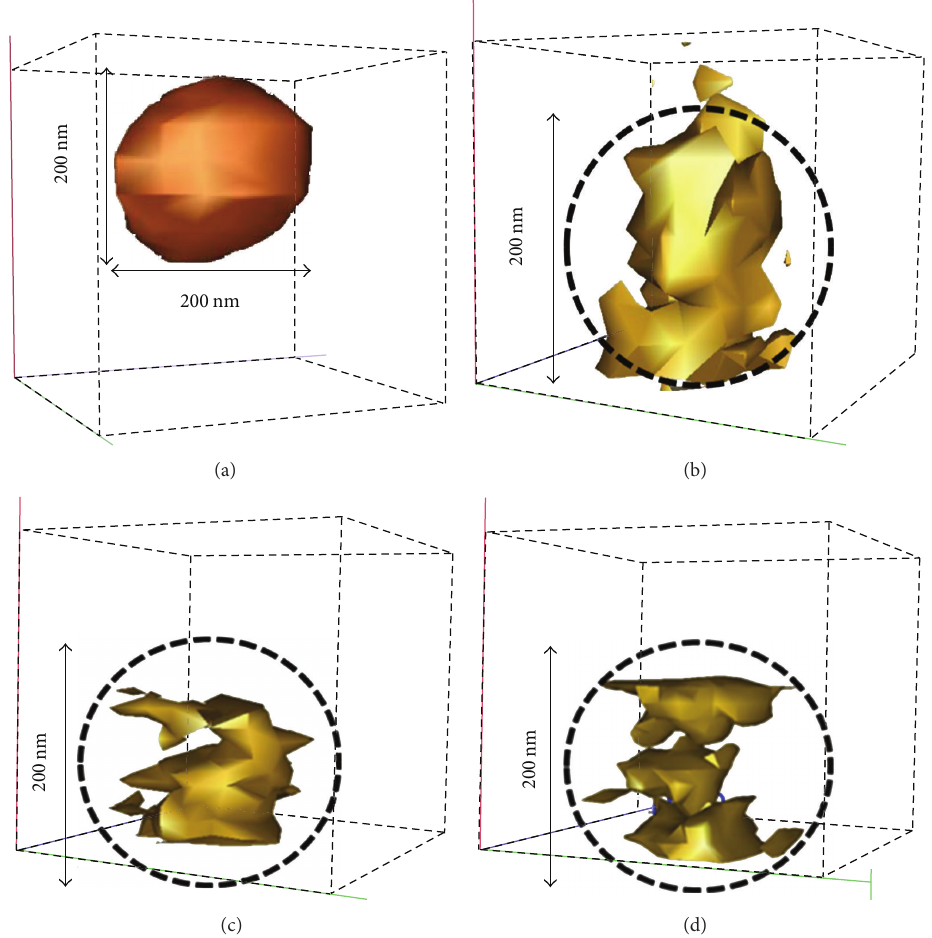
Figure 5: Three-dimensional images of a single nanoparticle: (a) surface image with general nonlinear confocal microscope ( 𝐼 = 1.0 W/cm 2 ), (b) inspection image with polarization interferometric linear confocal microscope ( 𝐼 = 8.0 W/cm 2 ), and (c)-(d) inspection images with polarization interferometric nonlinear confocal microscope ( 𝐼 = 1.0 × 10 2 W/cm 2 and 𝐼 = 2.5 × 10 3 W/cm 2